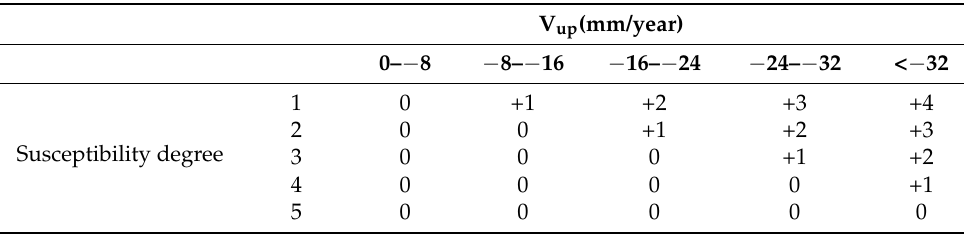
Table 2. Contingency matrix applied to the LSM considering the average Vup in each cell. (The susceptibility degree from 1 to 5 represents very low, low, moderate, high, and very high, respectively). V up